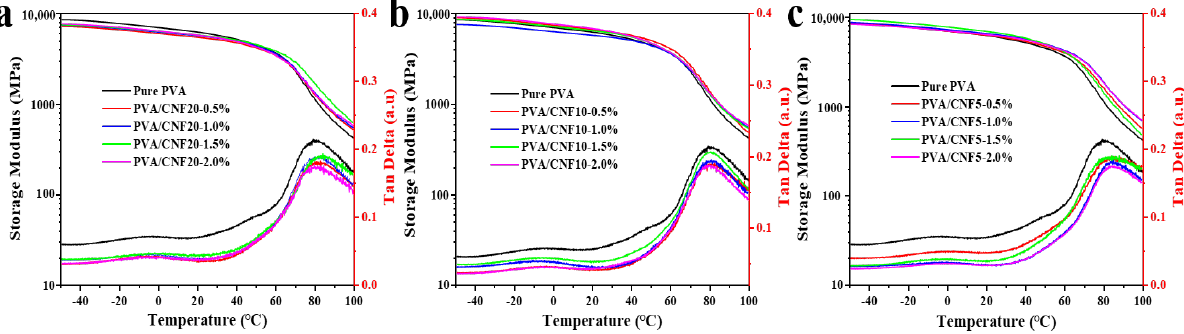
Figure 6. The DMA thermograms of neat PVA and PVA/CNF nanocomposites as a function of temperature: ( a ) PVA/CNF20; ( b ) PVA/CNF10; ( c ) PVA/CNF5. Table 4. The DMA data of PVA and PVA/CNF composites as a function of the CNF content. Samples